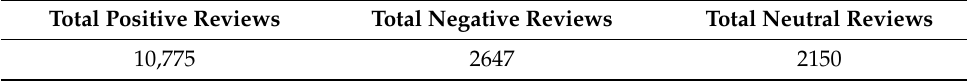
Table 1. Hotel reviews’ statistics of ElSahar and El-Beltagy dataset.